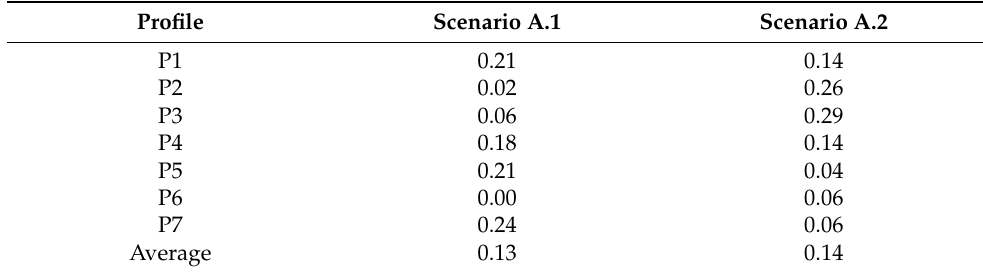
Table 4. Average retreat rates (cm/min) for z = 0.3 m contour.